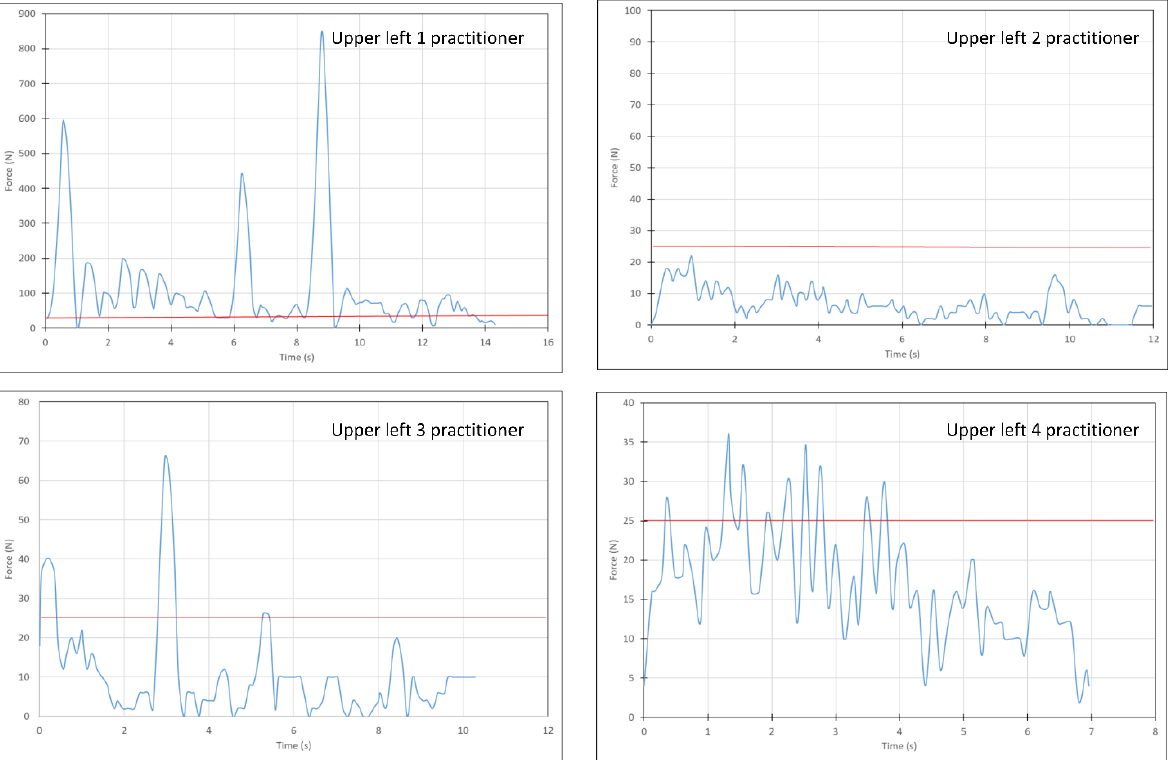
Figure 3. Characteristic force-time diagrams of Filtek specimen preparation in the upper left quadrant obtained from each practitioner. The local peak forces during the procedure were considered as above the minimum values of 25 Newtons (red solid line, see Figure 2).